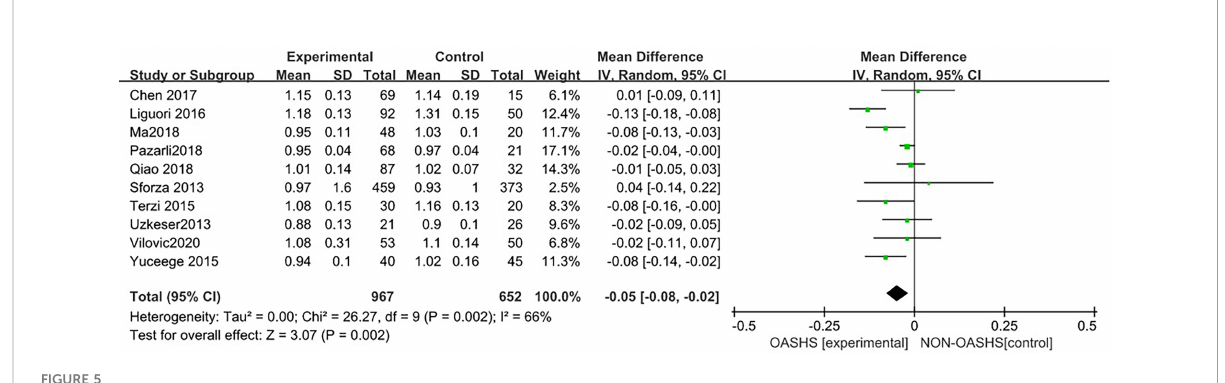
FIGURE 5 Forest plot of lumbar spine bone mineral density between OSAHS group and control group.